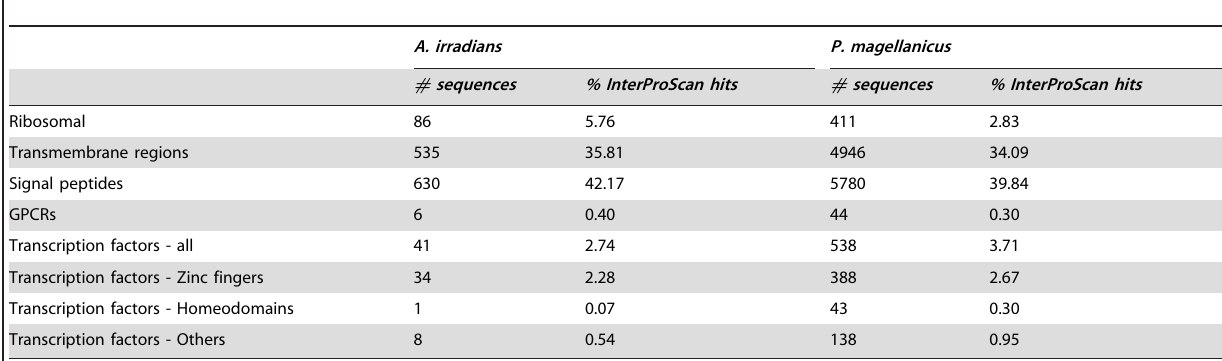
Table 4. Major categories of protein domains identified by InterProScan for A. irradians and P. magellanicus adult eye transcriptomes.